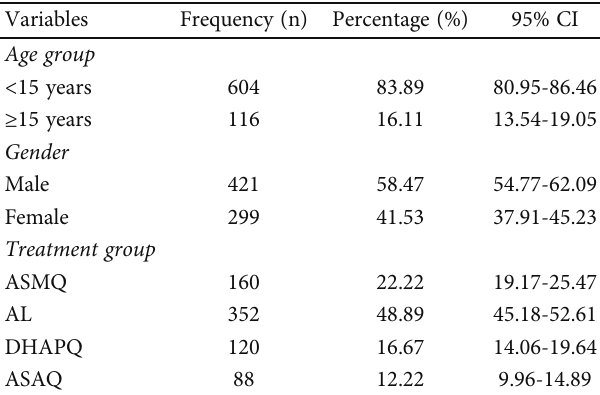
Table 1: Baseline characteristics of study participant at the inclusion ( n = 720